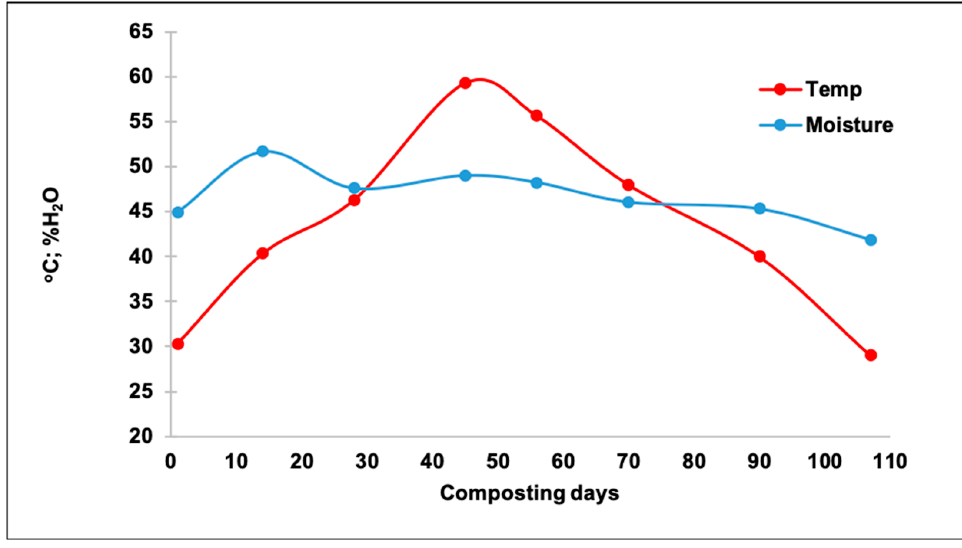
Figure 2. Changes in: temperature and moisture during the composting of municipal waste